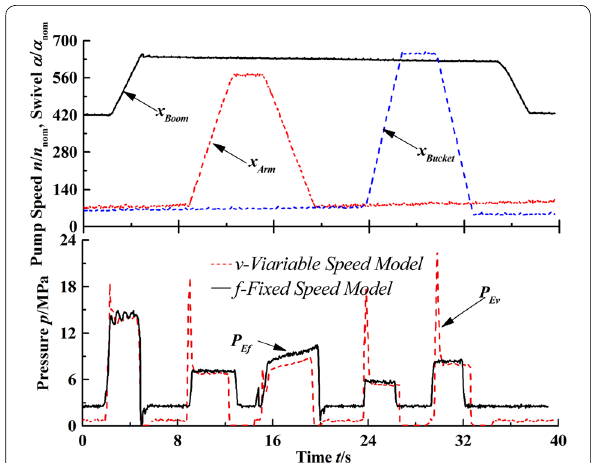
Figure 17 Electric power input and displacement of the